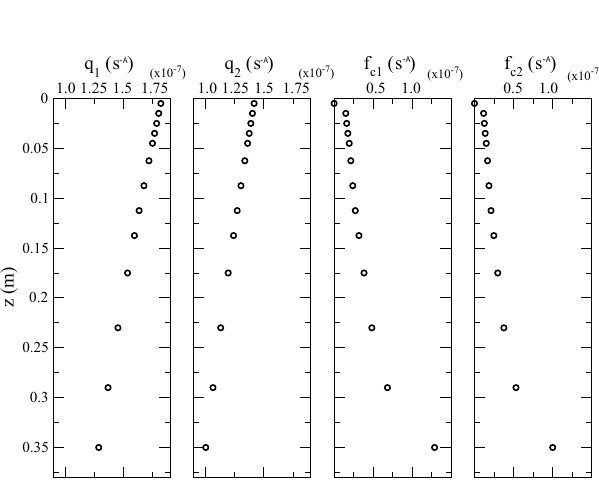
Figure 3. Sink term q and correction source term f c over depth z added to the flow and transport equations, respectively. q 1 and f c1 are applied between rain pulses 1, 2, and 3, while q 2 and f c2 are applied after rain pulse